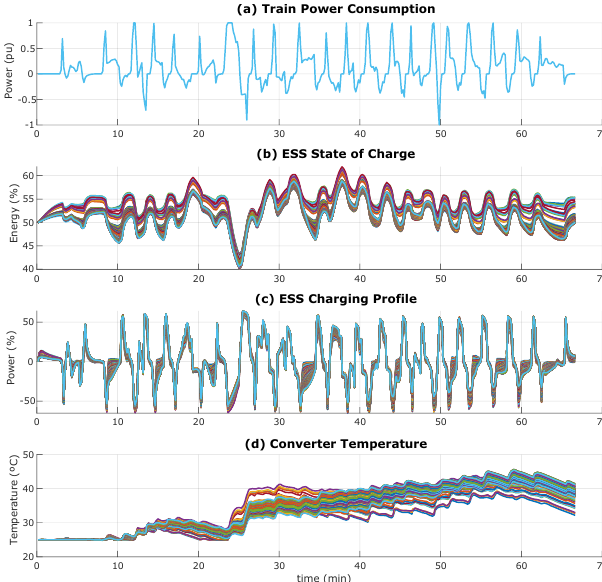
Figure 10. Evolution of testbed variables, in order of time, for different meta-heuristic generations of fuzzy rule weights: (a) Power consumption for one journey; (b) Stored energy; (c) Charging profile; and (d) Converter temperature.